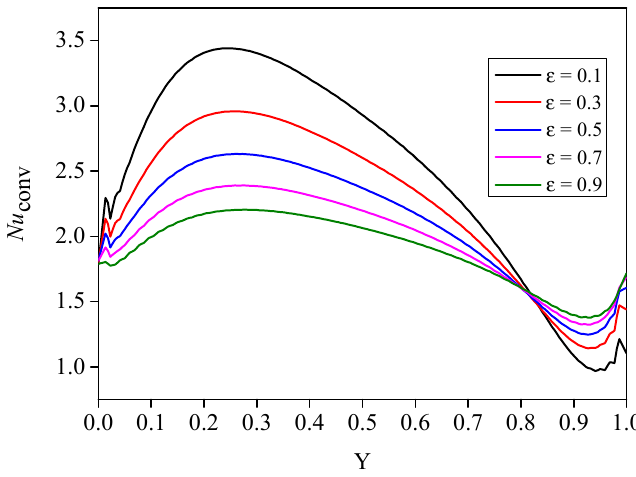
Figure 8. Variations of the local Nusselt number at different ε .